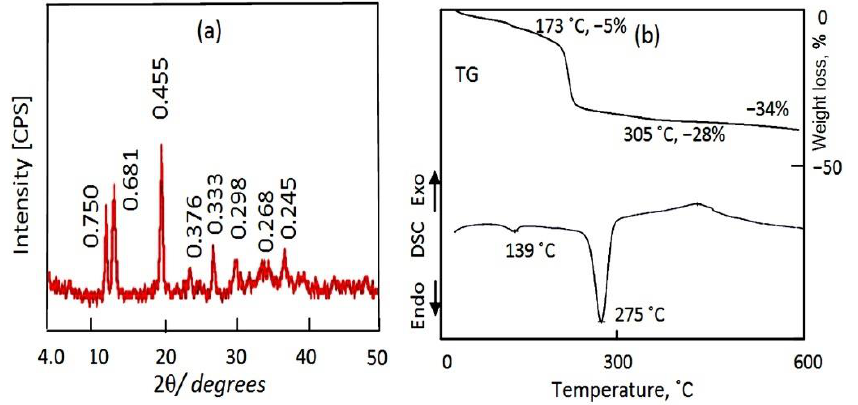
Figure 5. The AZ-2 sample: ( a ) X-ray diffraction, and ( b ) thermal analyses. The first structure is made clear by observing three peaks at 2Ѳ = 11.79°, 23.40° and 33.35°, which agree with the d-spacing of 0.750 nm, 0.376 nm and 0.268 nm. The good arrangement and similarities between the value of 0.750 nm, the double value of 0.376 and the triple value of 0.268 nm indicate a nanolayered structure, agreeing with the hy- drotalcite-like materials (JCPDS file No. 37-629). This means that the first structure of AZ- 2 is the nanolayered structure of zinc aluminum hydroxide carbonate hydrate.